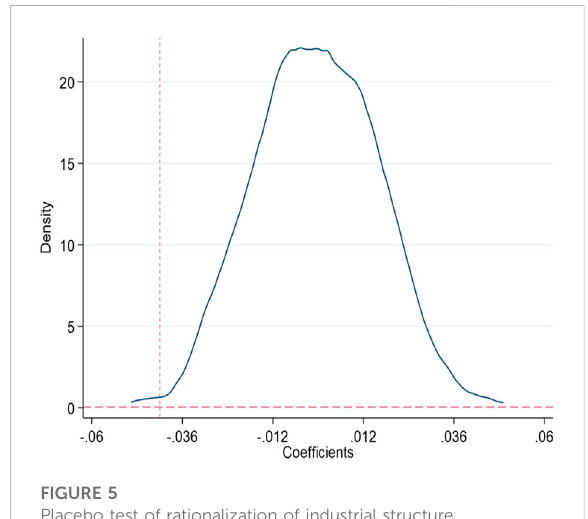
FIGURE 4 Placebo test of advanced industrial structure.